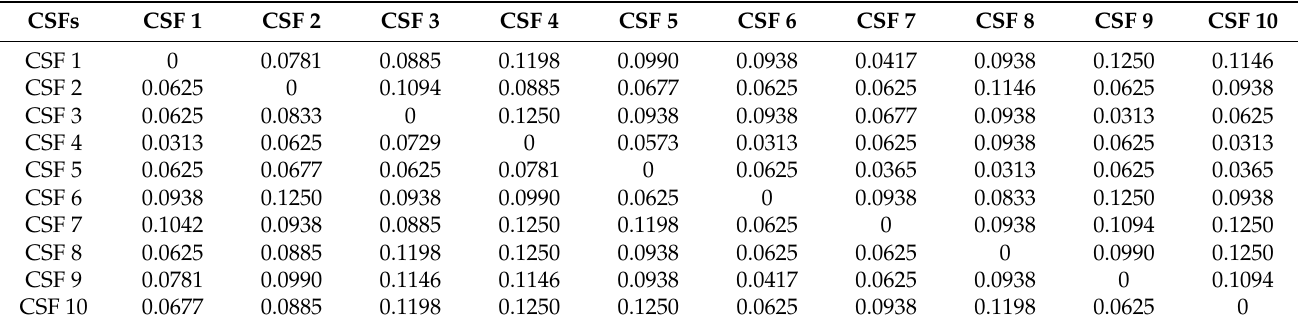
Table 5. Normalized direct-relation matrix (D).